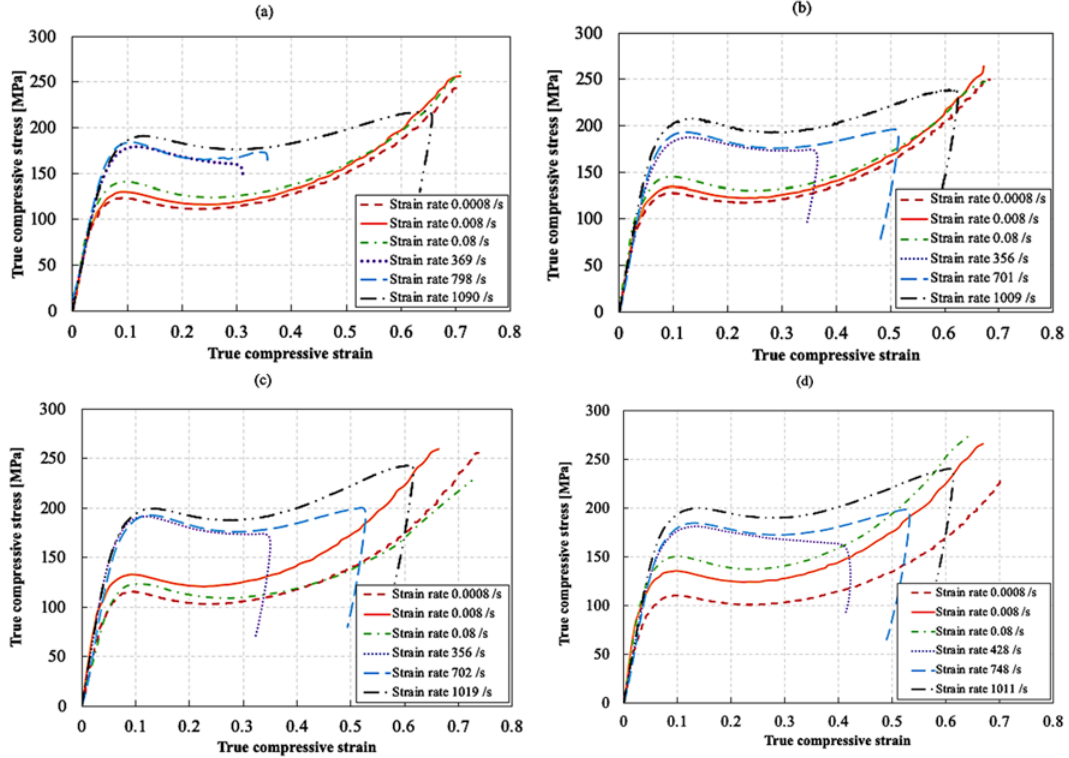
Figure 16. True stress–strain curves at different strain rates for ( a ) neat epoxy, ( b ) 0.1 wt%, ( c ) 1 wt% and ( d ) 5 wt% AHBP epoxy resins.